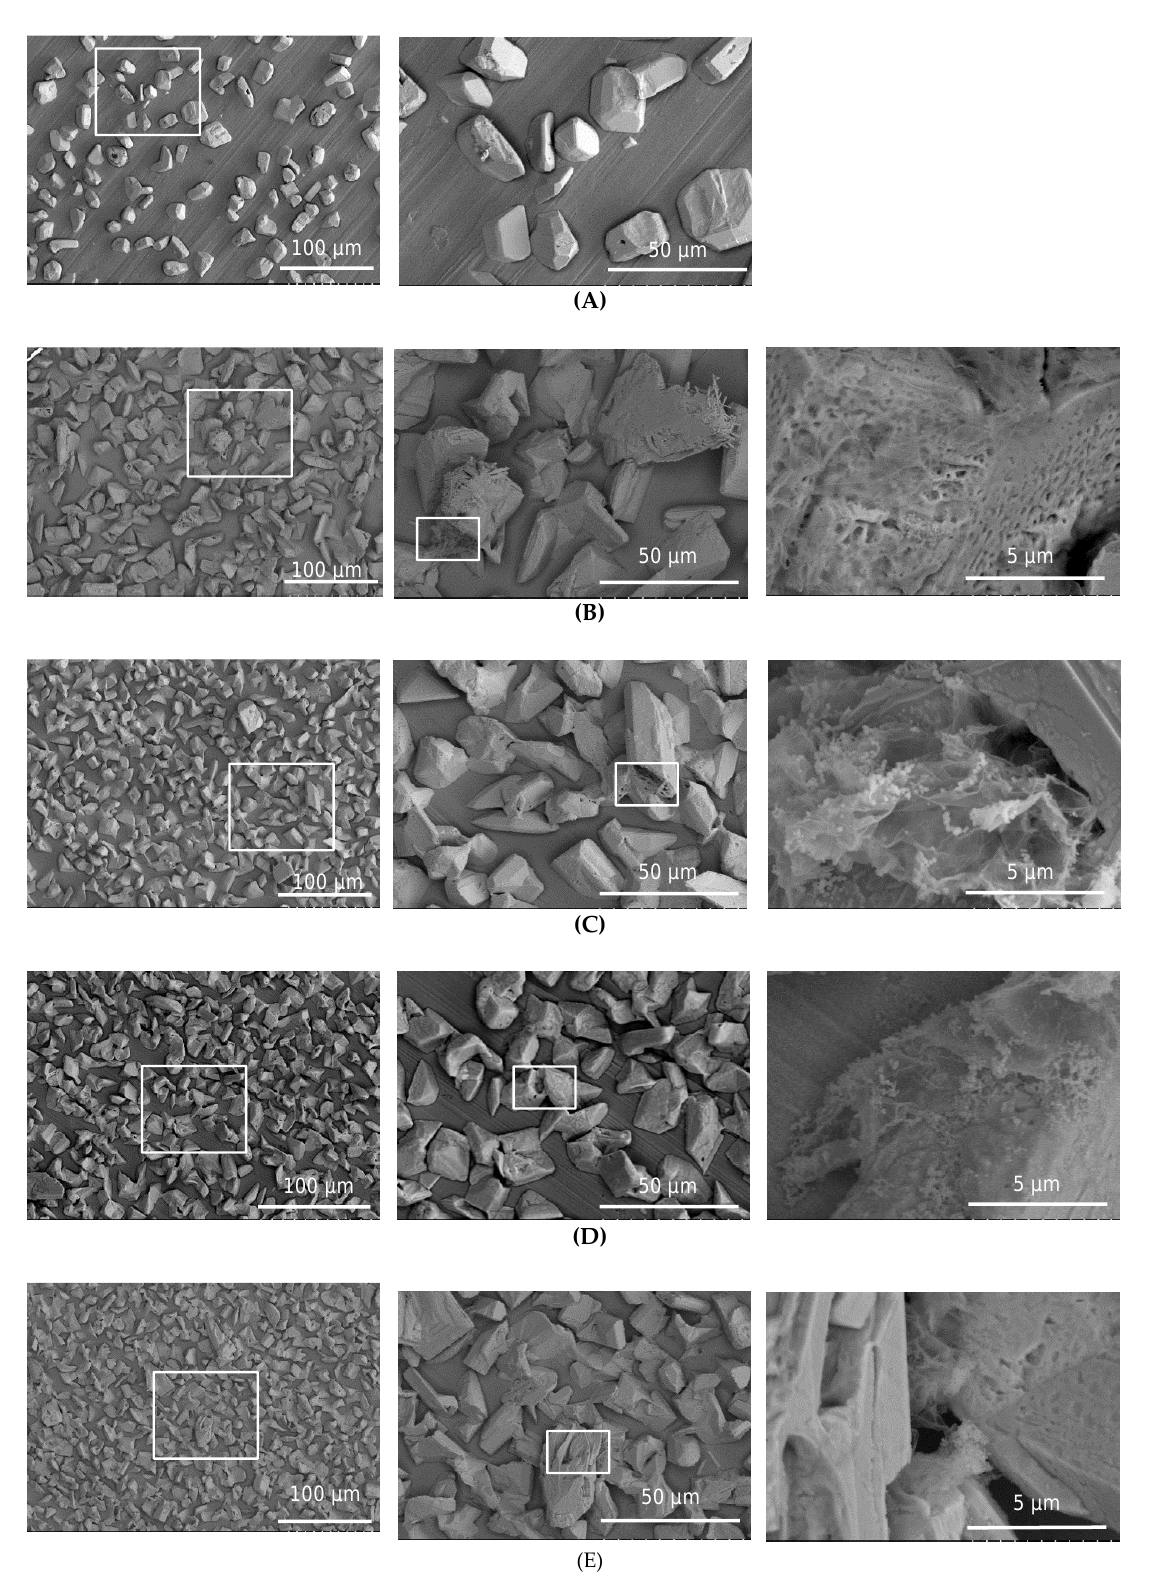
Figure 7. SEM images of: ( A ) Sn film electrodeposited at 15 mA cm − 2 from ILEG + 0.7 M SnCl 2 and ( B – E ) Sn-rGO film electrodeposited from ILEG + 0.7 M SnCl 2 + 20 mg L − 1 GO at different current densities: ( B ) 15 mA cm − 2 , ( C ) 20 mA cm − 2 , ( D ) 25 mA cm − 2 , ( E ) 30 mA cm − 2 ; temperature 70 ◦ C, electric charge 18 C cm − 2 , different